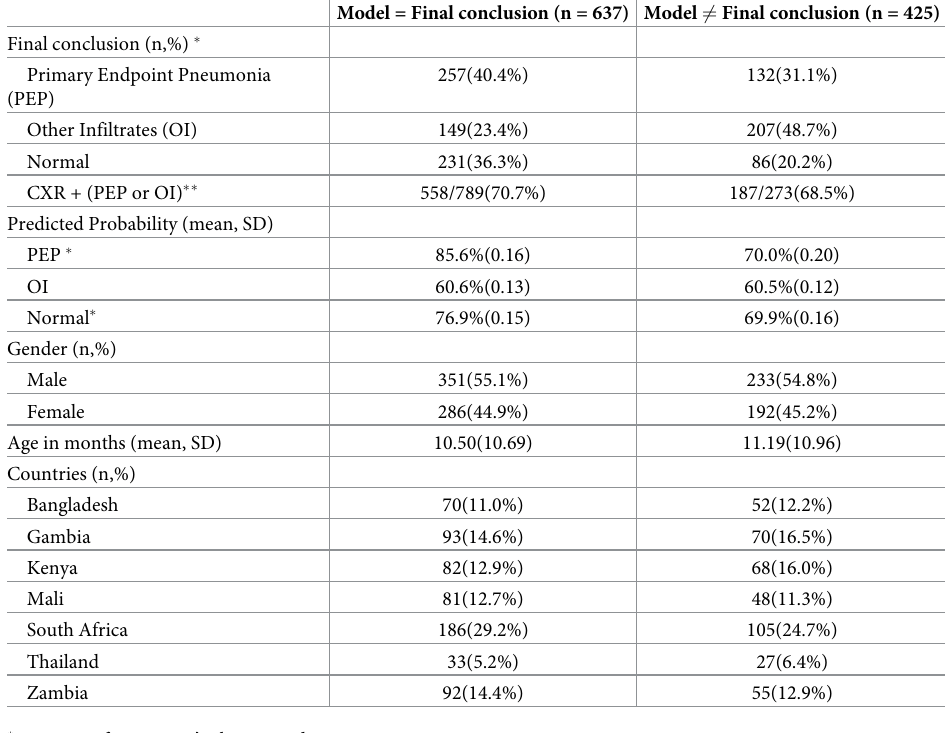
Table 3. Final conclusion and model prediction on discordant CXR images (N = 1,062) by key